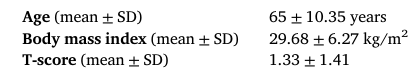
Table 1 Characteristics of